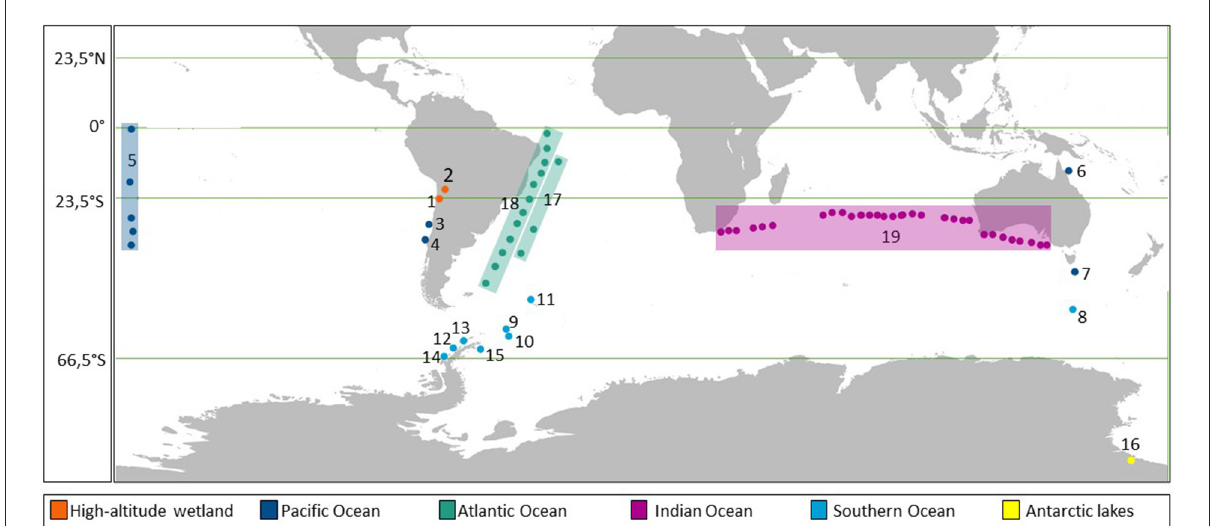
FIGURE2 Map showing the areas and sampling sites analyzed in this work from the Southern hemisphere. The numbers (ID) show the areas sampled and colored squares indicate sampled transects.